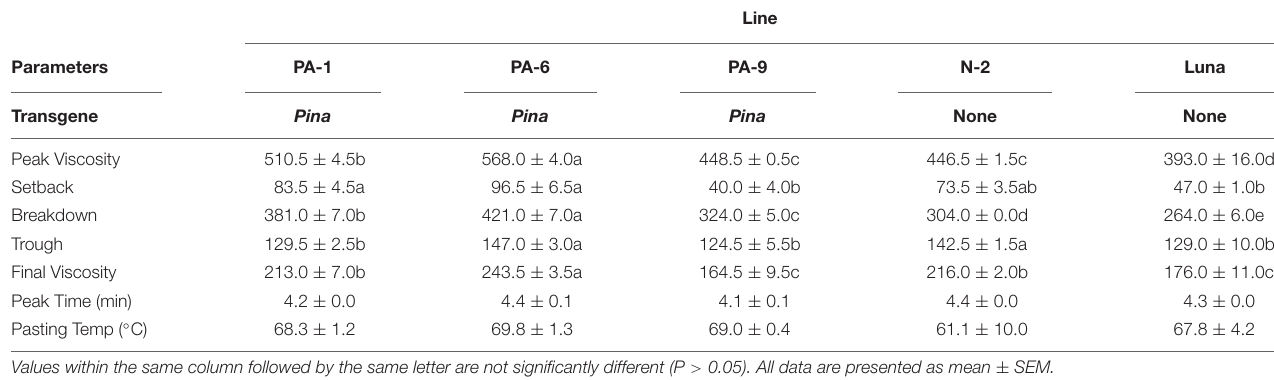
TABLE 3 | RVA properties of the transgenic and control lines.